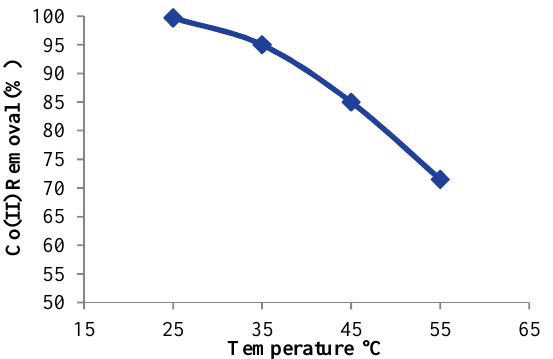
Figure 6. Effect of temperature on the removal efficiency of Co(II) by NiFe 2 O 4 nanoparticles (C 0 = 60 mg/l, solution pH = 7, dose of adsorbent = 0.02 g, contact time = 70 minutes, and temperature = 25